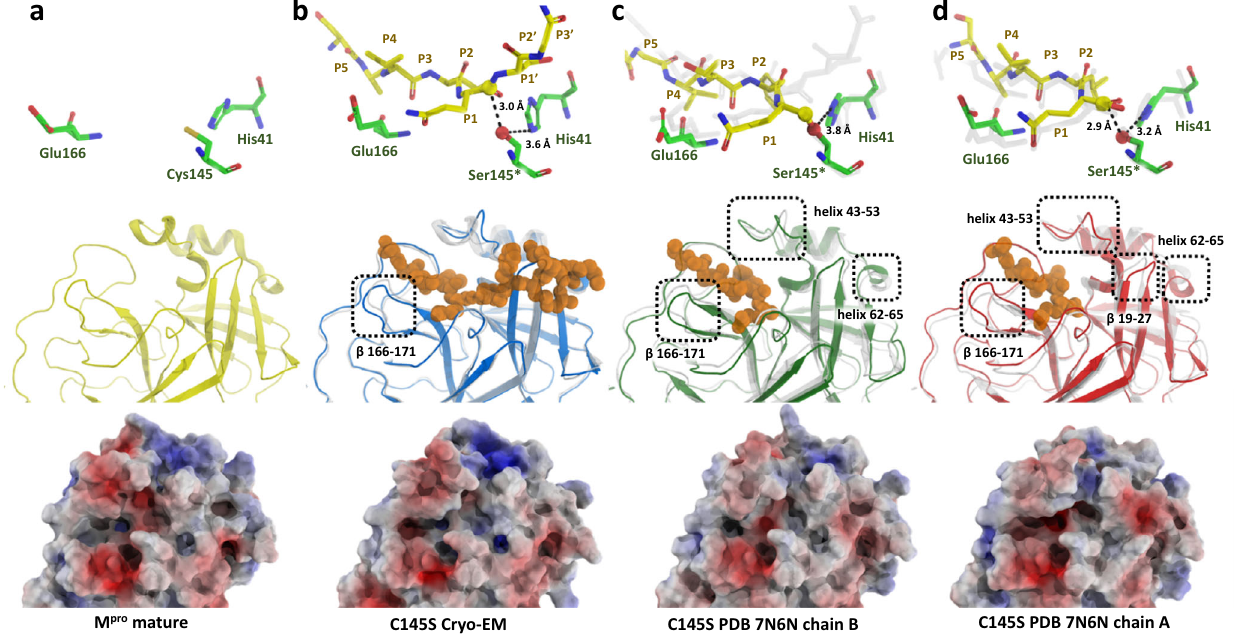
Fig. 8 | Active site comparison between apo and intermediary states of M pro . a Key active site residues (green sticks) of M pro in apo form (top), cartoon view of active site in apo state in yellow (middle) and calculated electrostatic potential projectedintosurfaceofM pro activesite(bottom). b Keyactivesiteresidues(green sticks)ofM pro C145Sboundtointactpeptide(top),cartoonviewofactivesitefrom the respective form (middle) and calculated electrostatic potential projected of respective form (bottom). c Key active site residues (green sticks) of M pro C145S covalently bound to cleaved peptide forming the enzyme-substrate intermediary